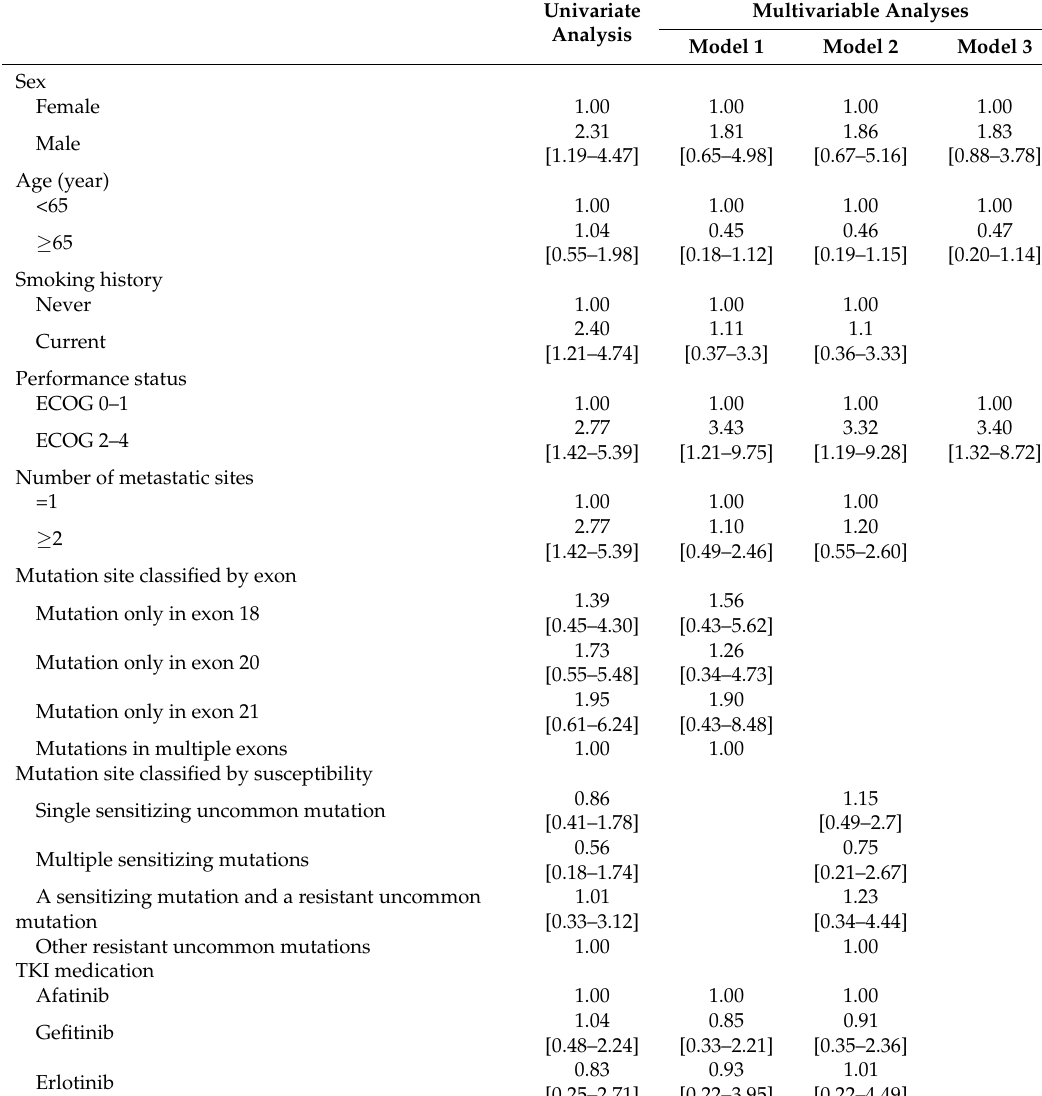
Table 7. Cox proportional hazards regression analyses for identifying the relationship between clinical features and overall survival in patients with stage IV lung cancer harboring uncommon mutation receiving first-line